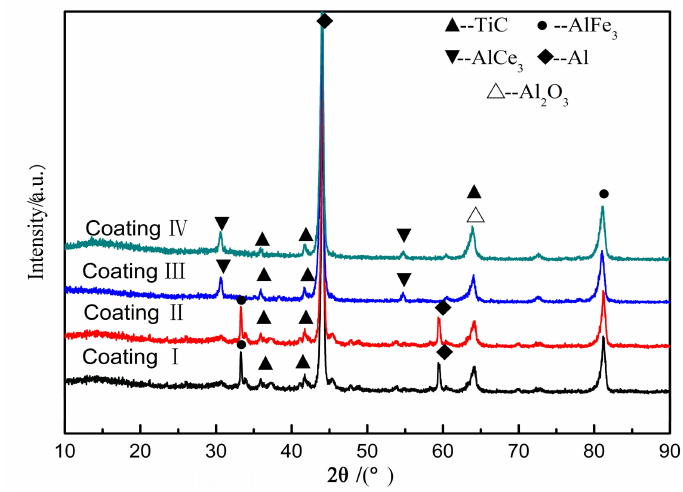
Figure 2. XRD patterns of cladding layer under different laser